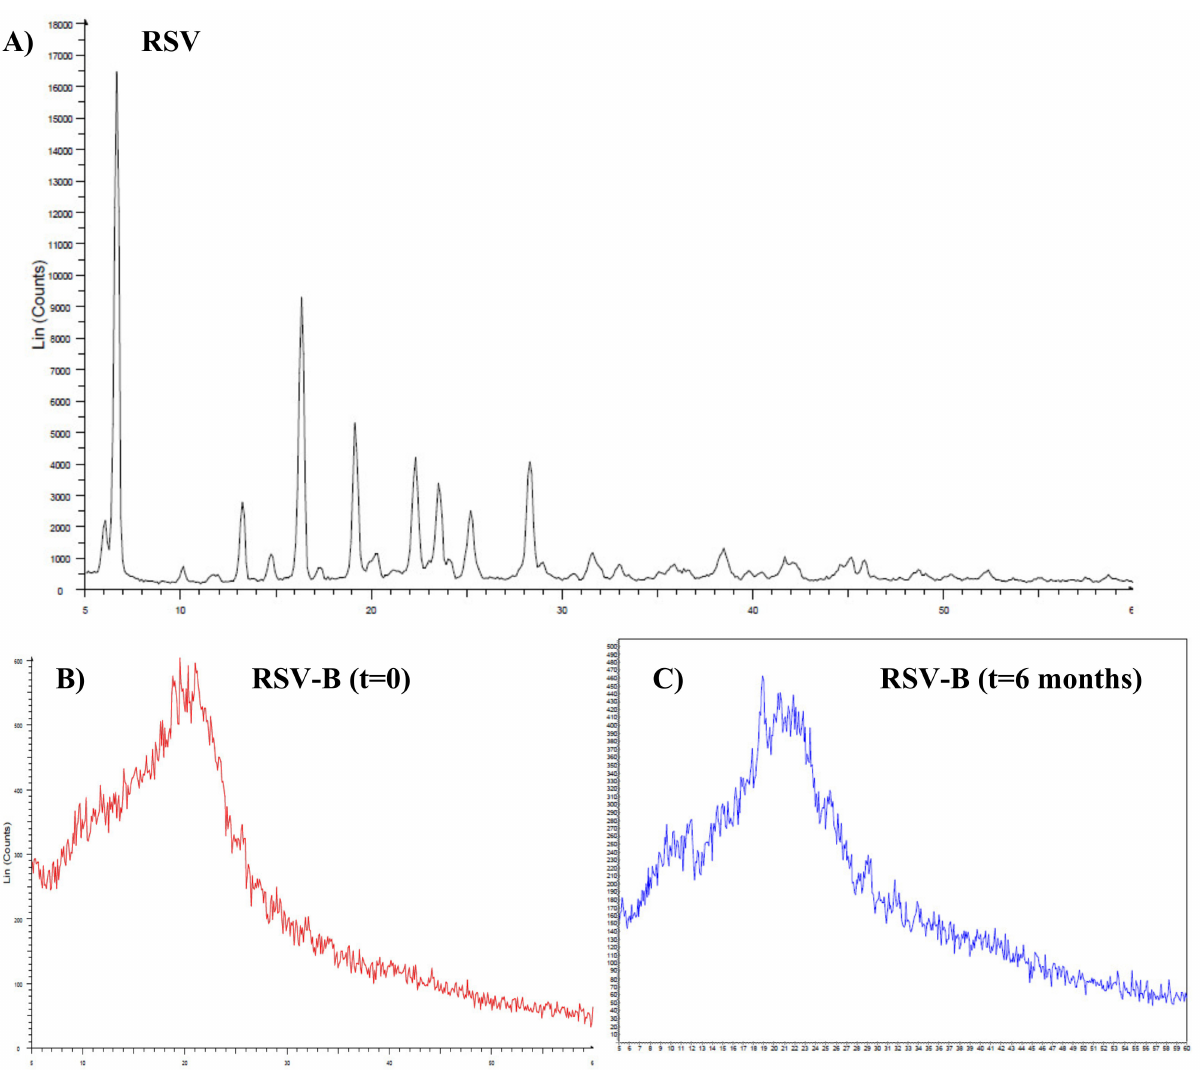
Figure 9. Diffractograms of ( A ) pure RSV, ( B ) RSV-B immediately after preparation and ( C ) RSV-B after a 6-month storage